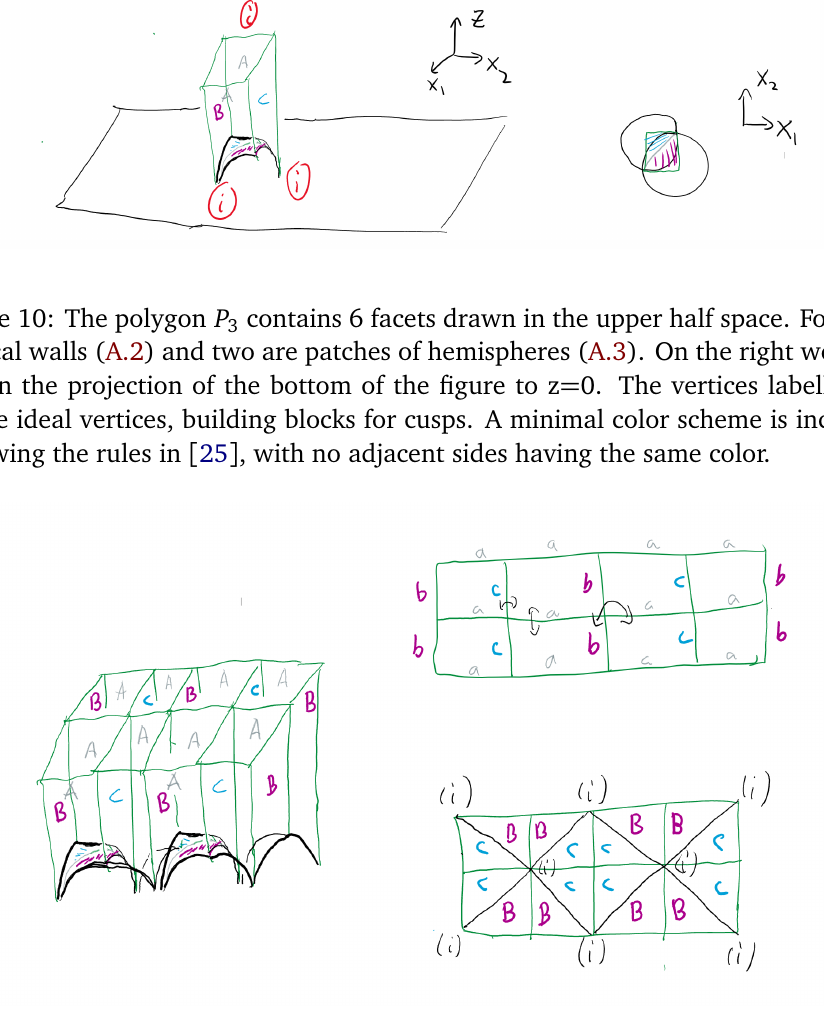
Figure 11: Sketch of the space obtained by mirroring across each color once. On the left we sketch the entire space. The opposite vertical walls are identified. The upper right is a top view giving the cross section of the cusp at z → ∞ (a.k.a.